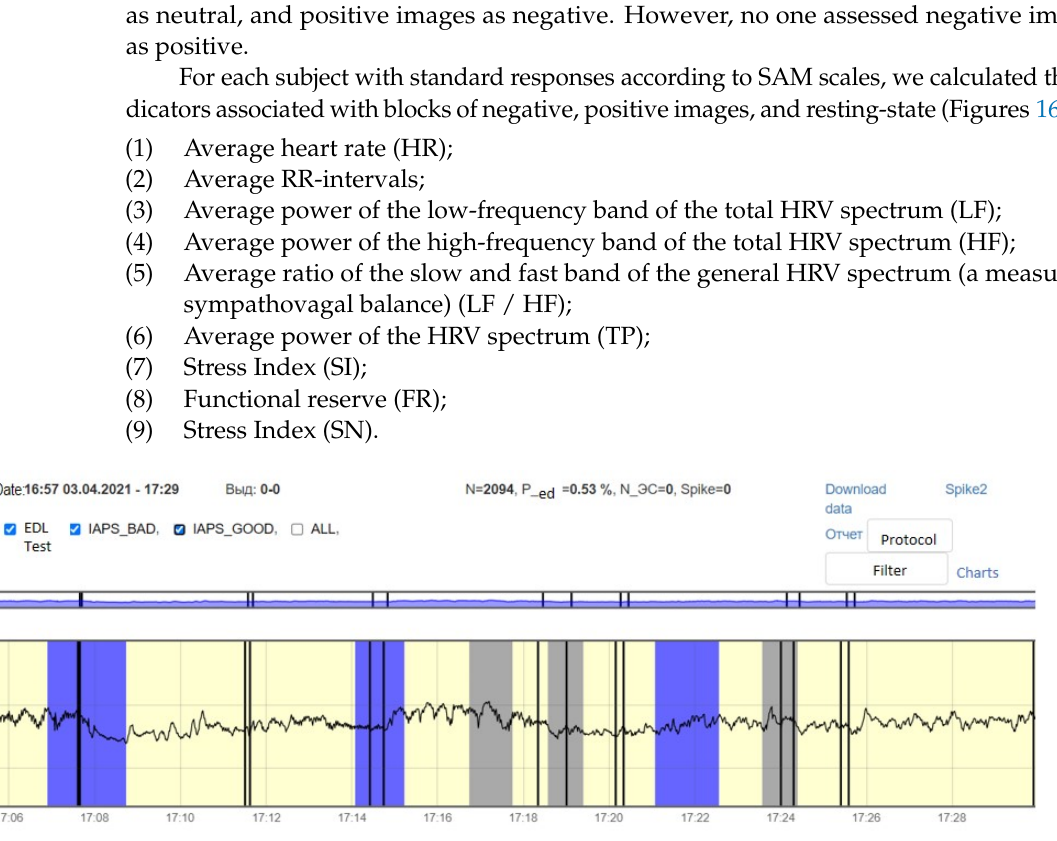
Figure 17. Calm state case. Figure 18. Worsening state case. Figure 19. State optimization markers depending on the functional effect.